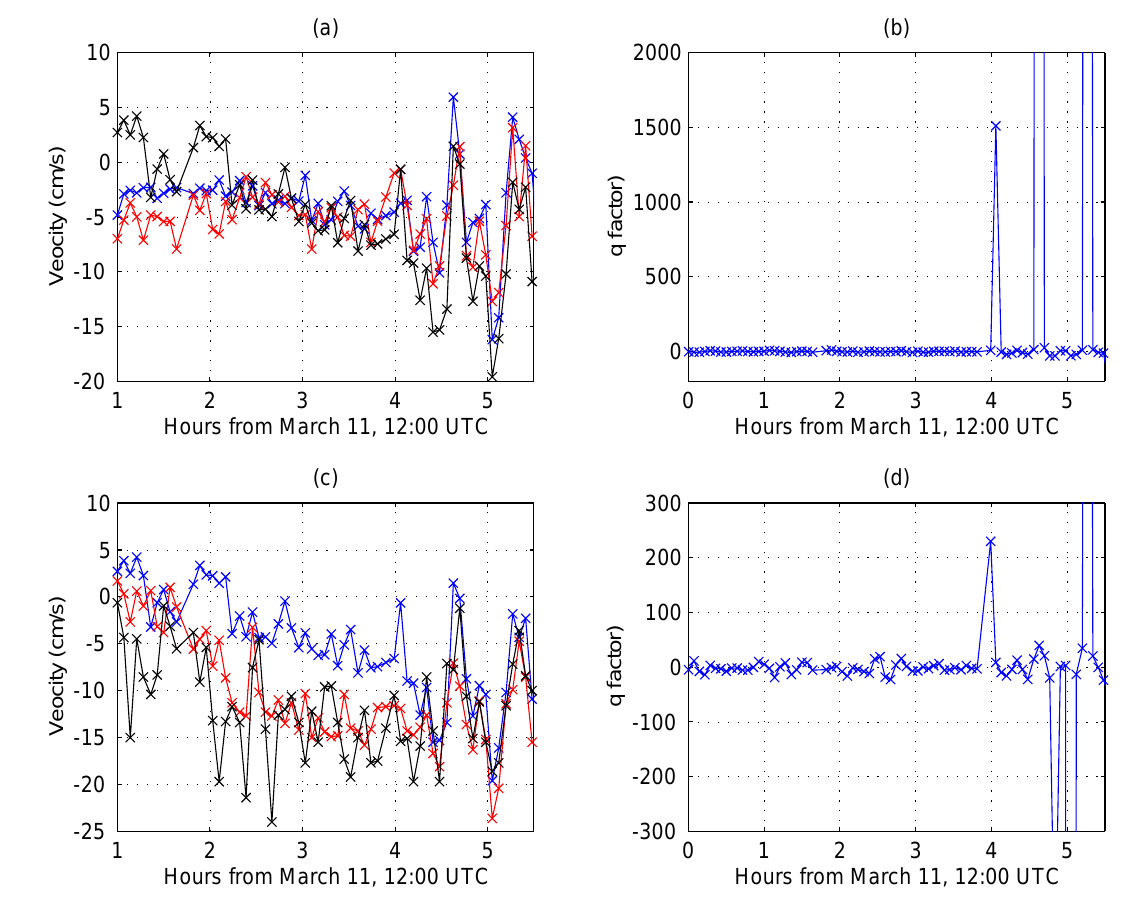
Figure 9. Time series of velocity components from radar ESTR ( a ) Blue: 2–4 km; Red: 4–6 km; Black: 6–8 km ( b ) q-factor for 2–8 km offshore ( c ) Blue: 8–10 km; Red: 10–12 km; Black: 12–14 km. ( d ) q-factor for 8–14 km offshore.